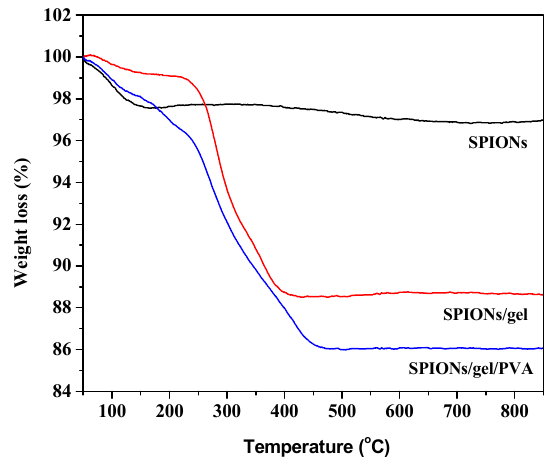
Figure 5. Thermographs of SPIONs, SPIONs/gel and SPIONs/gel/PVA.